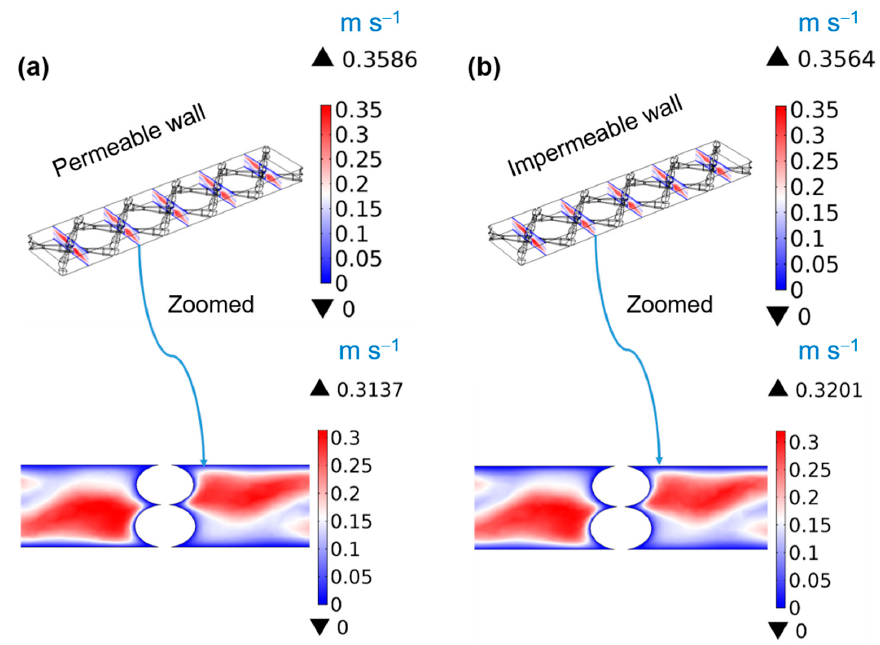
Figure 4. The velocity magnitude distributions with an inlet average velocity magnitude of 0.15 m s − 1 using ( a ) the permeable wall model (Case 1: L P = 1 L m − 2 h − 1 bar − 1 ) and ( b ) the impermeable model.